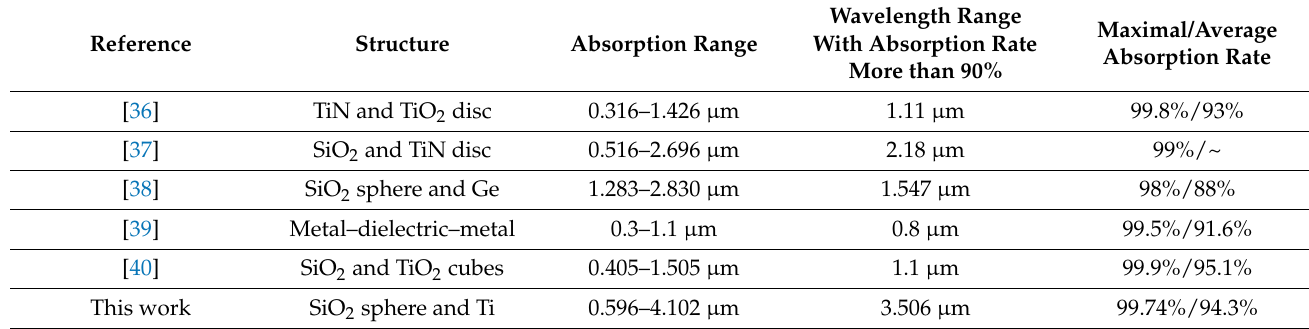
Table 1. Absorption range of different structures with an absorption rate of more than 90%.